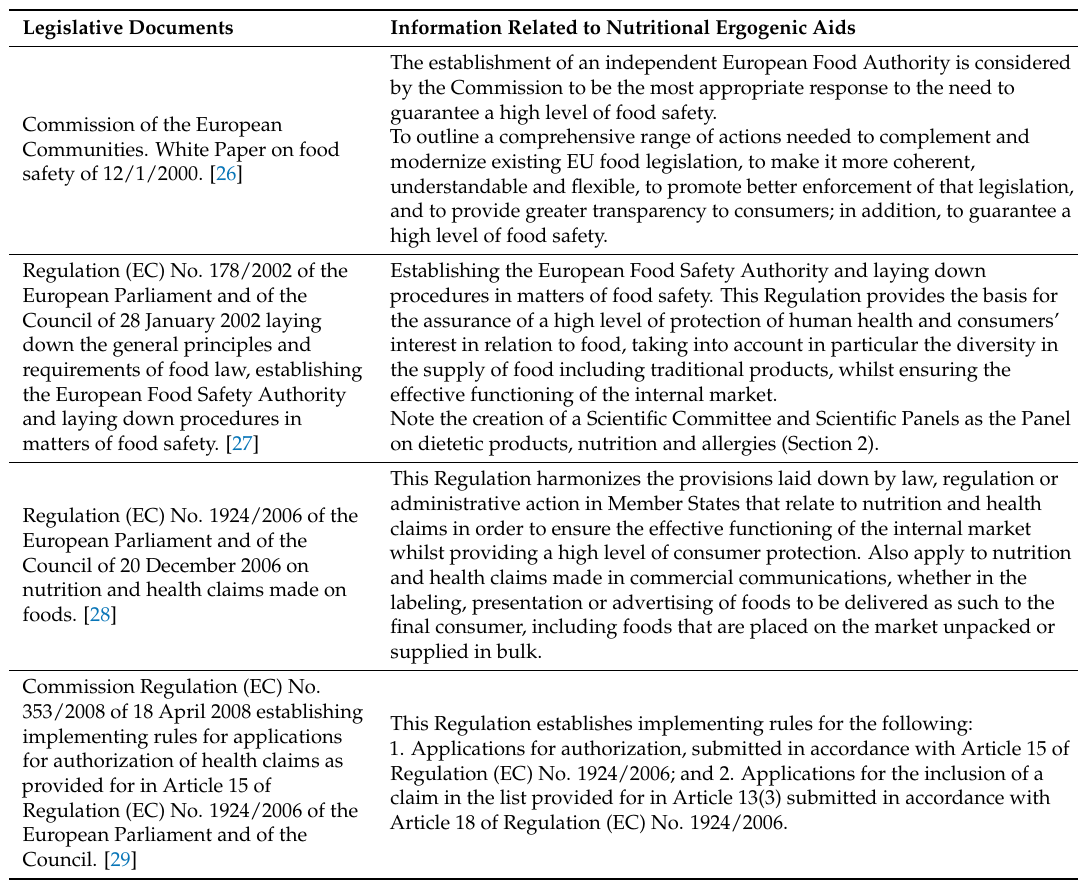
Table 2. Legislative documents on composition, labeling, and advertising of